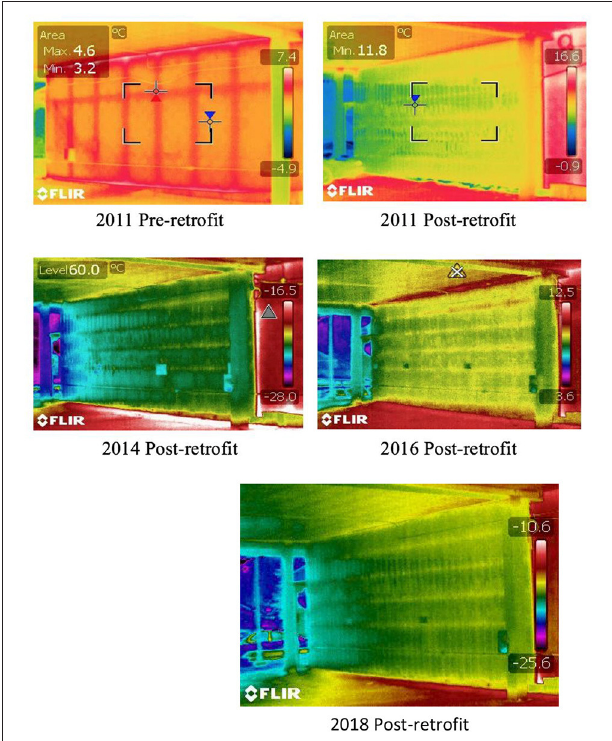
FIGURE 7 | Infrared images of the pre-retrofit and post-retrofit wall. Images were taken in 2011, 2014, 2016, and 2018.